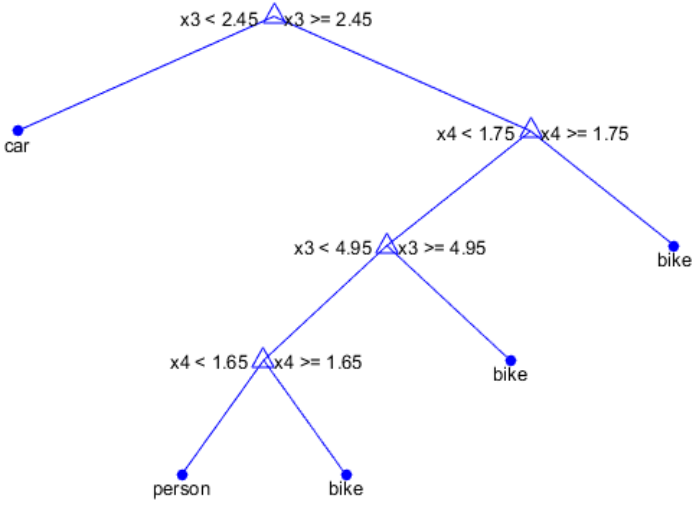
Figure 4. Random Forest Tree example.